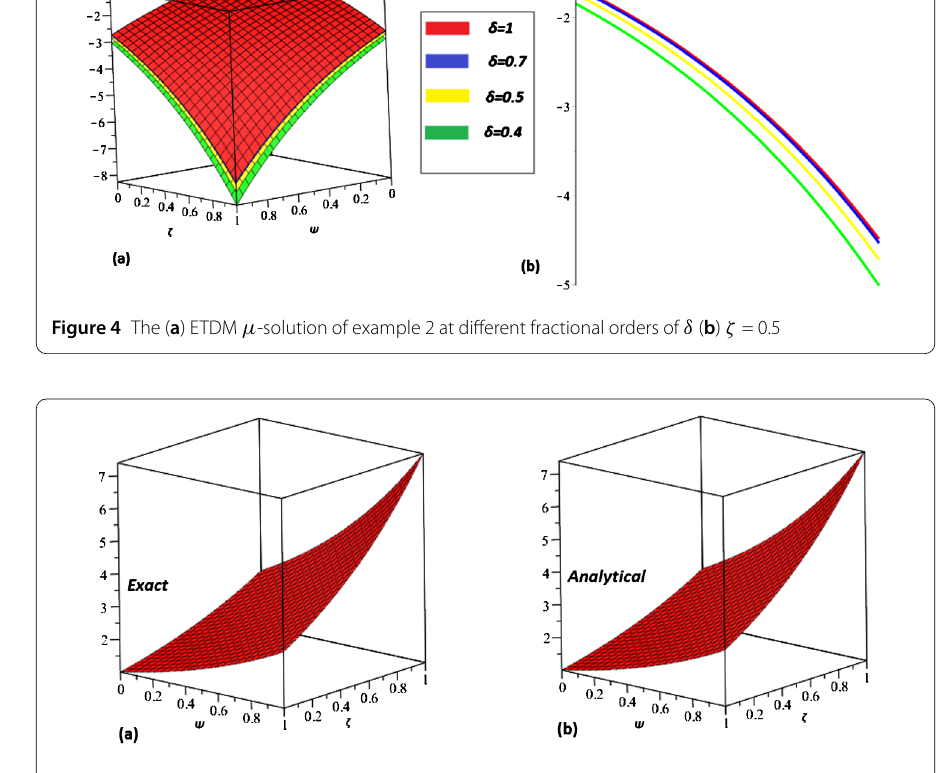
fractional solutions for variable nu by using sub-graphs (a) and (b) of example 2 in both two and three dimensions. It is observed that the ETDM solutions are in good contact with the actual solutions of example 2. In Fig. 7, the exact and ETDM μ -solutions are compared at δ = 1 of example 3. The comparison has shown a very close relation between the actual and ETDM solutions. In Fig. 8, the exact and ETDM solutions at δ = 1 of example 3 are represented by the sub-graphs (a) and (b) respectively. In Fig. 9, various fractional-order solutions of example 3 are presented in both two and three dimensional space. In Fig. 10, the ω -exact and ETDM solutions are plotted which confirmed to close relation